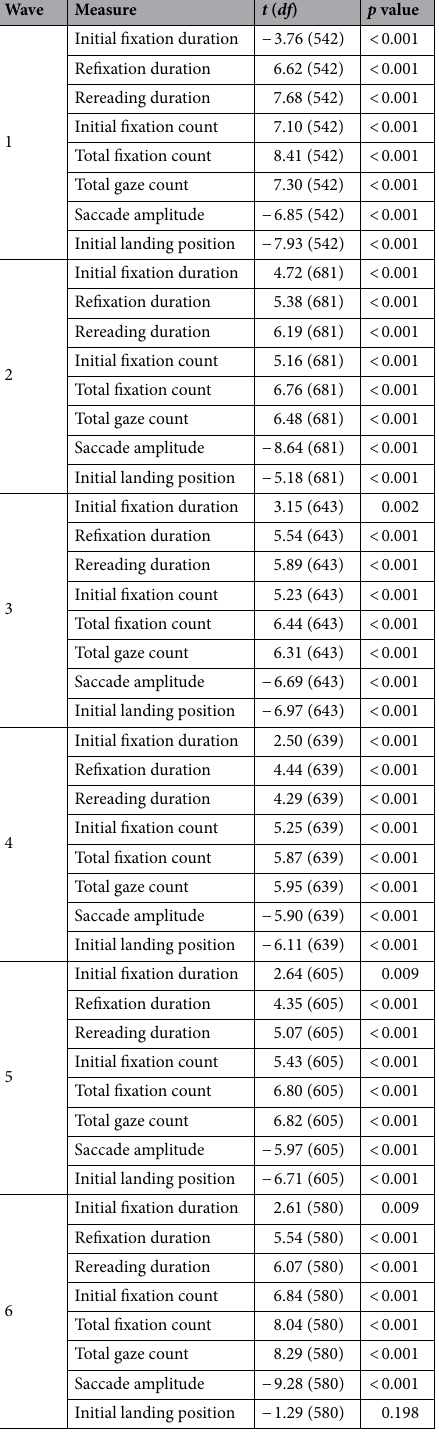
Table 2. Mean comparisons between oral versus silent reading mode among eye-tracking measures by